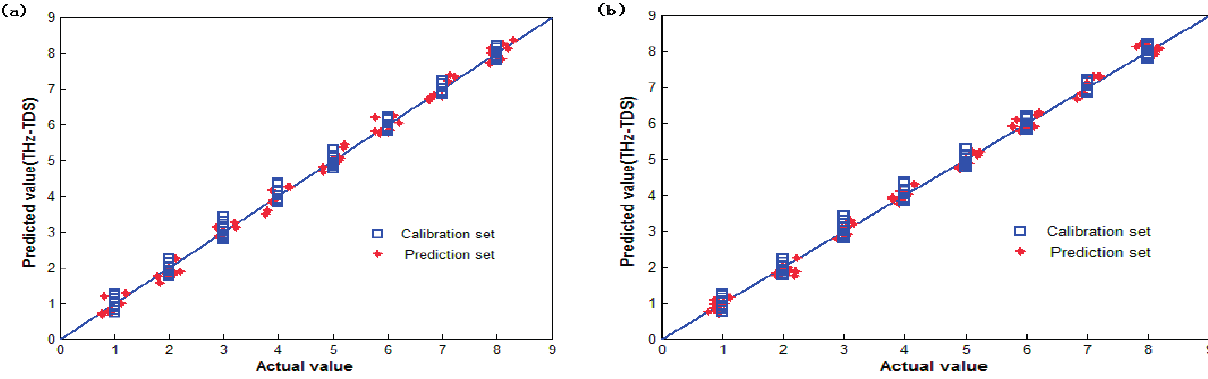
Figure 6. Scatter plots of the actual value vs. the predicted value for the discrimination of wheat varieties using ( a ) the full-spectrum PLS calibration model and ( b ) the iPLS calibration model based on the selected subinterval in the range 0.787–0.9